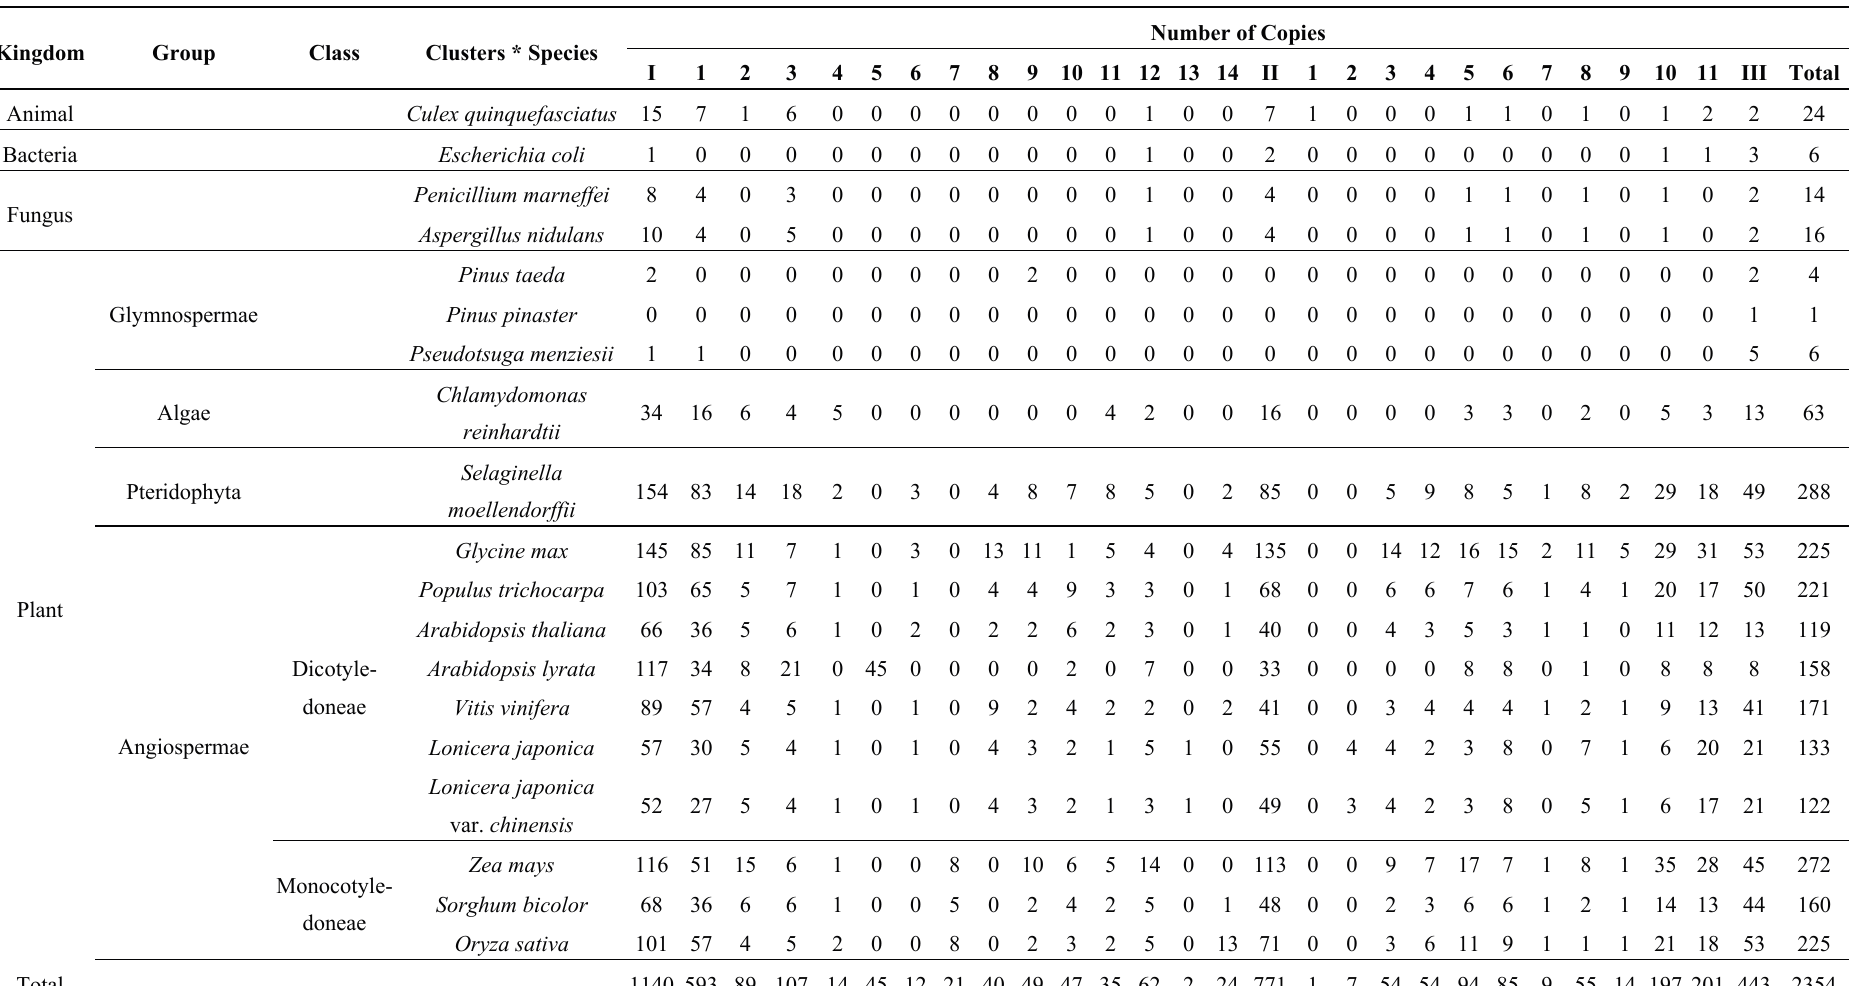
Table 1. Copy number of S -adenosyl- L -methionine-dependent methyltransferases ( SAMe ) in 19